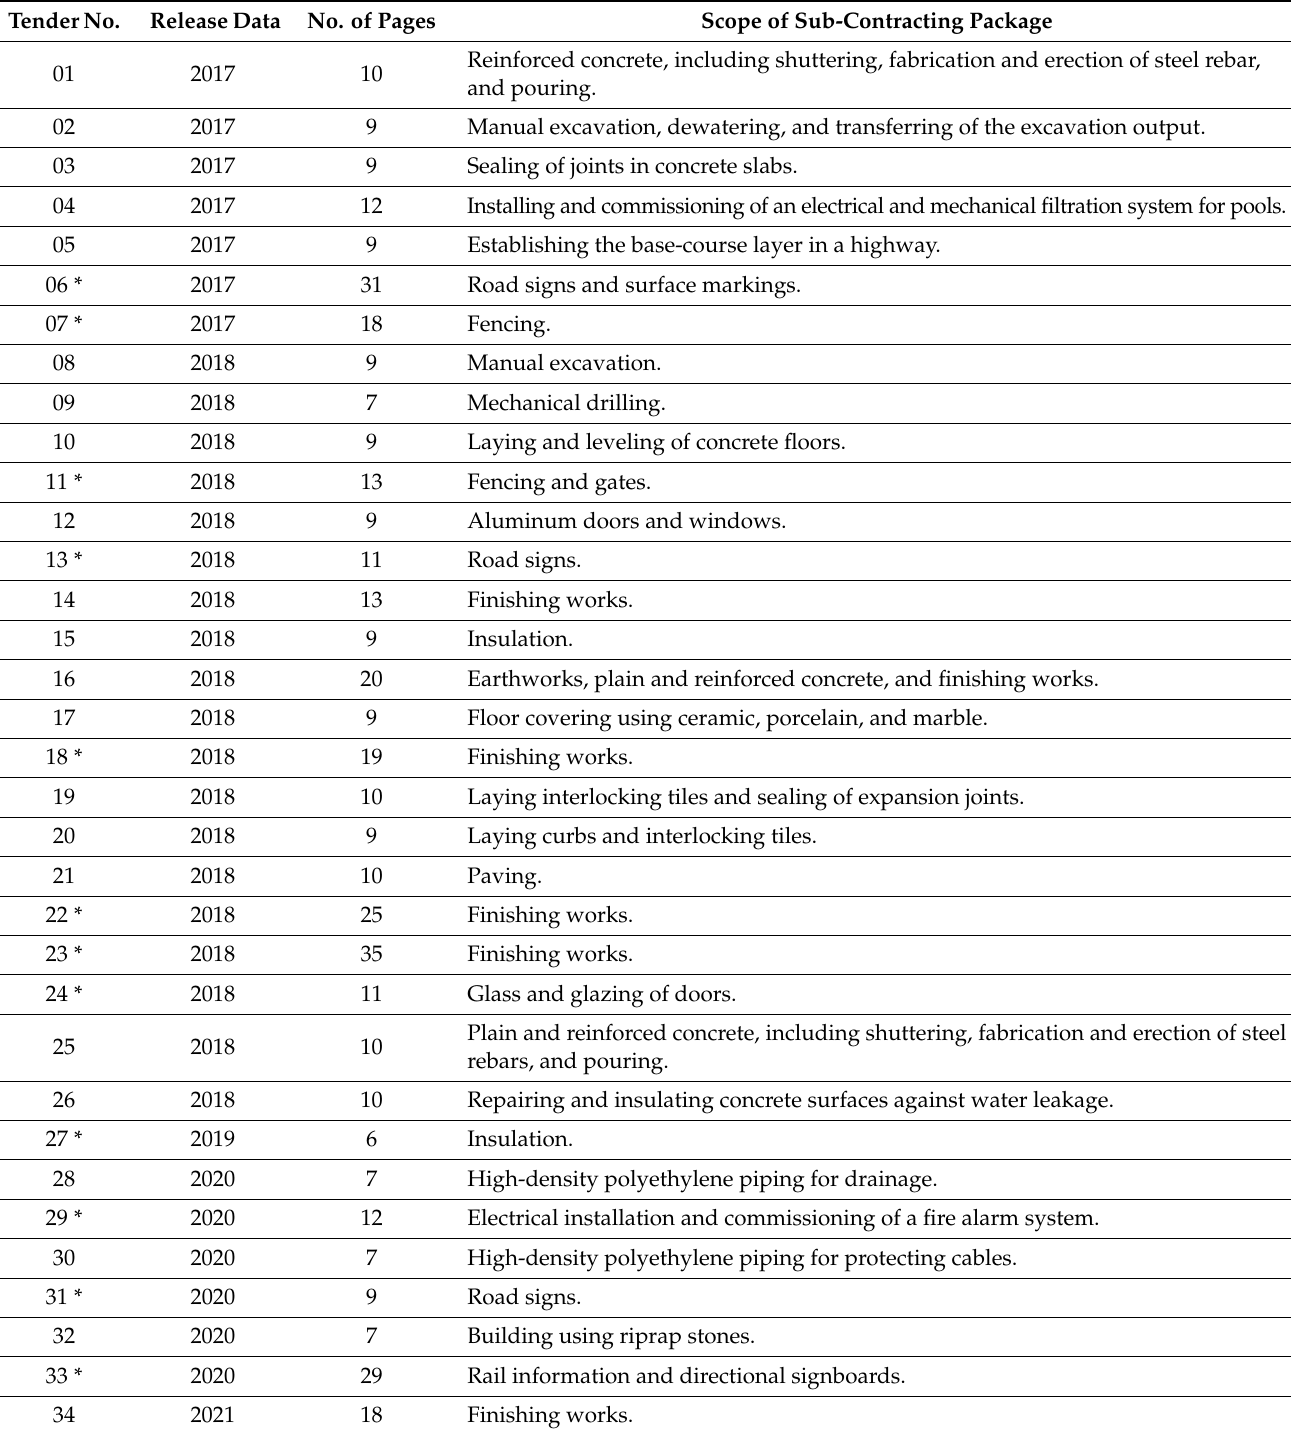
Table 1. Tender documents